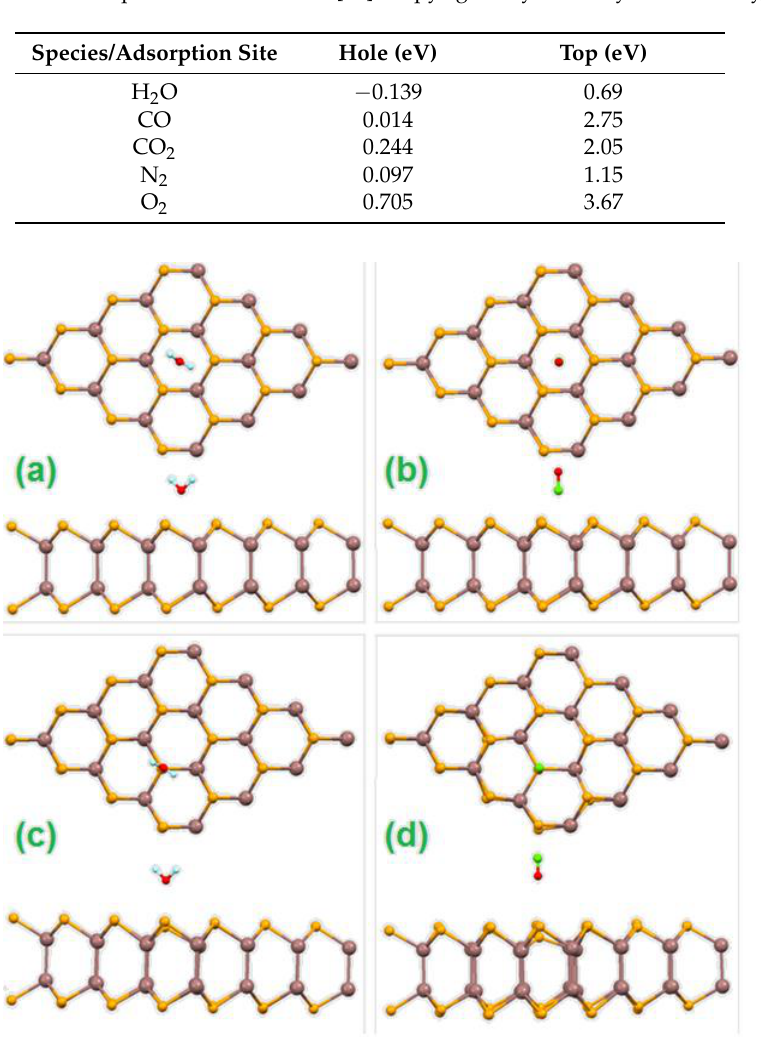
Table 1. Adsorption energies of different ambient species over the hole and on-top with respect to Se atoms. Reproduced with permission from Ref. [20]. Copyright Royal Society of Chemistry, 2016.